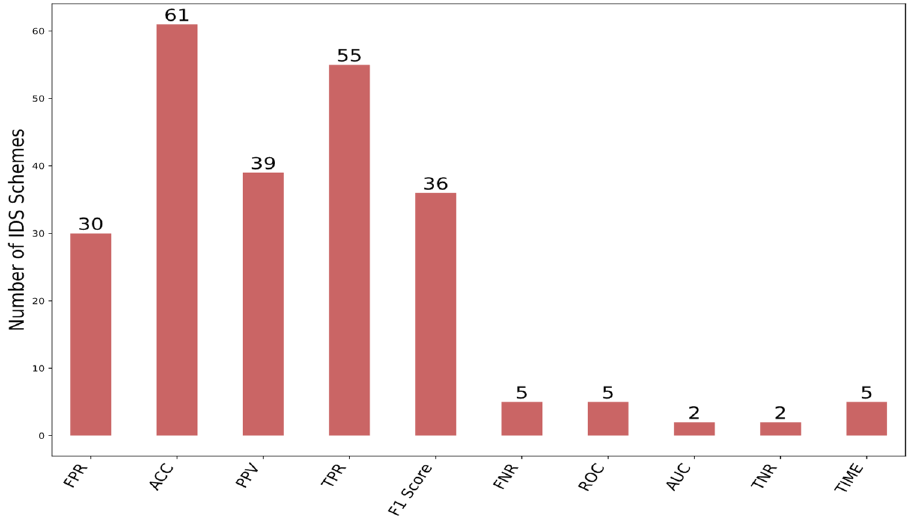
Figure 9. The number of IDS schemes that have applied each evaluation metric.